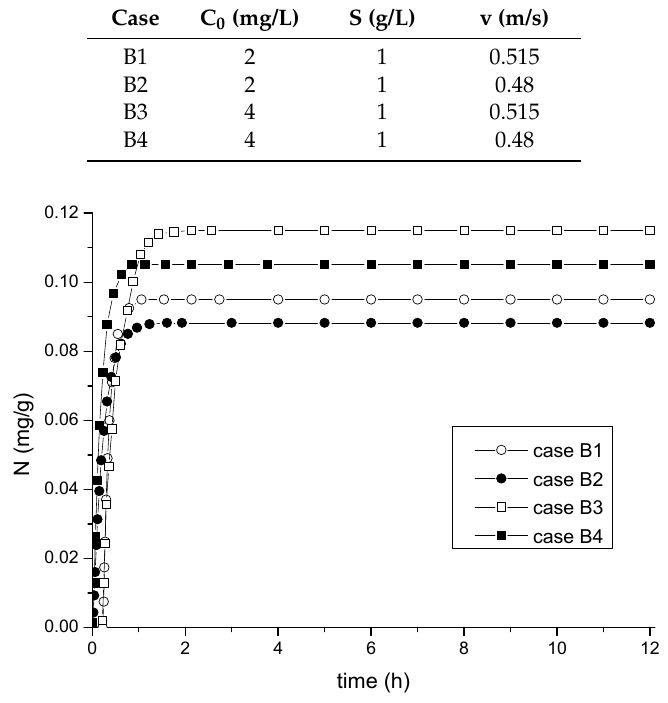
Table 3. The initial phosphorus concentration C 0 , initial sediment concentration S, and the cross-sectional average velocity v of different cases in the numerical simulations.